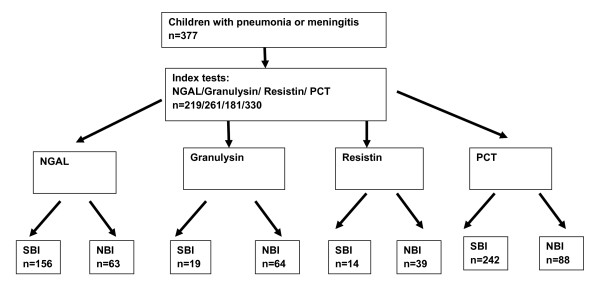
Flow diagram showing the number of patients undergoing index tests and the number of patients with SBI and NBI. The numbers of patients that had each measurement of are shown, according to STARD guidelines
[27]. All available samples were tested for all four biomarkers in the following order, procalcitonin, granulysin, NGAL, resistin, as long as there was remaining sample. A total of 181 samples were tested across all four assays.